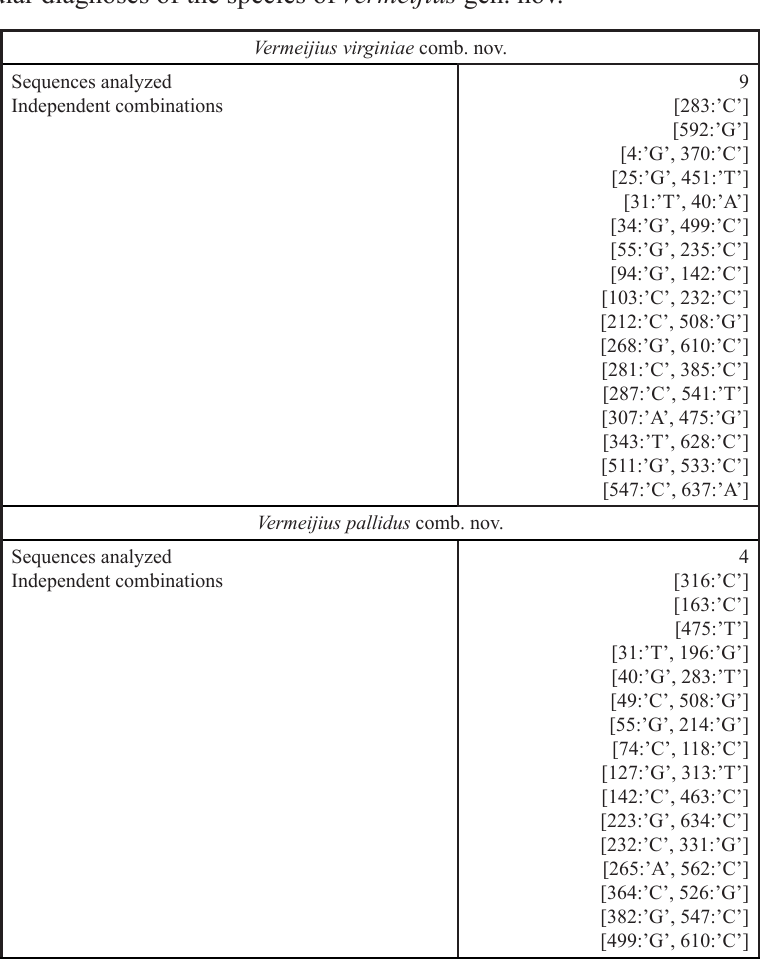
European Journal of Taxonomy 433: 1–57 Table 4. Molecular diagnoses of the species of Vermeijius gen. nov.